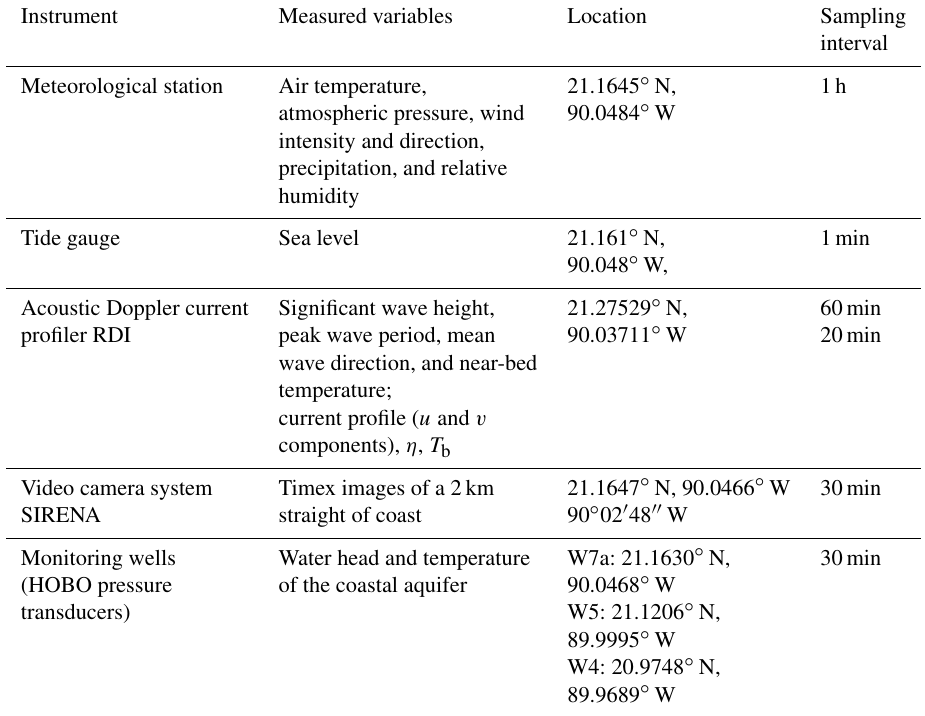
Table 1. Instruments and measured